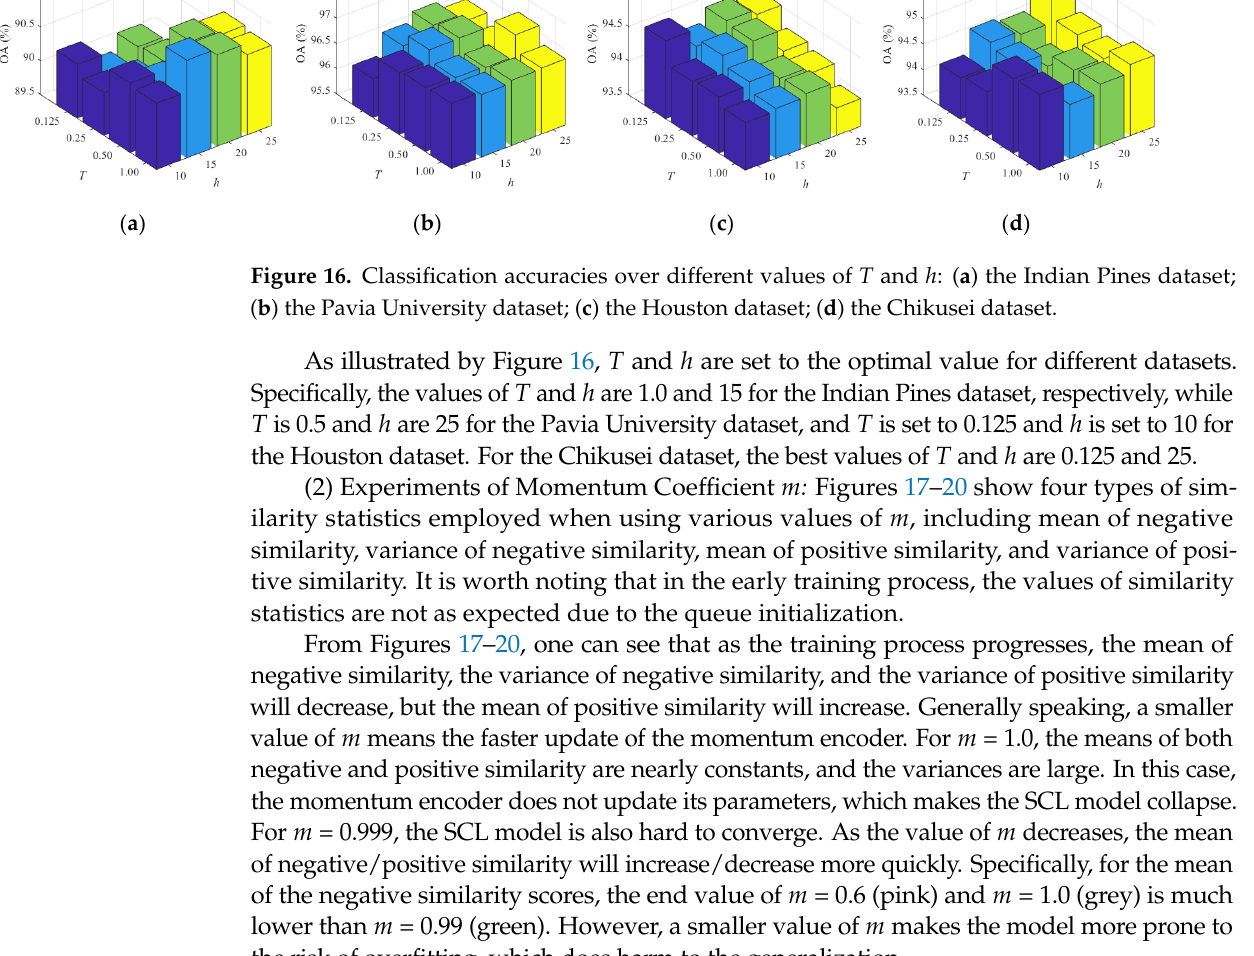
Figure 17. Similarity statistics of various 𝑚 in SCL training on the Indian Pines dataset: ( a ) mean of negative similarity; ( b ) variance of negative similarity; ( c ) mean of positive similarity; ( d ) variance of positive similarity. Different colors corresponds to different values of 𝑚 .